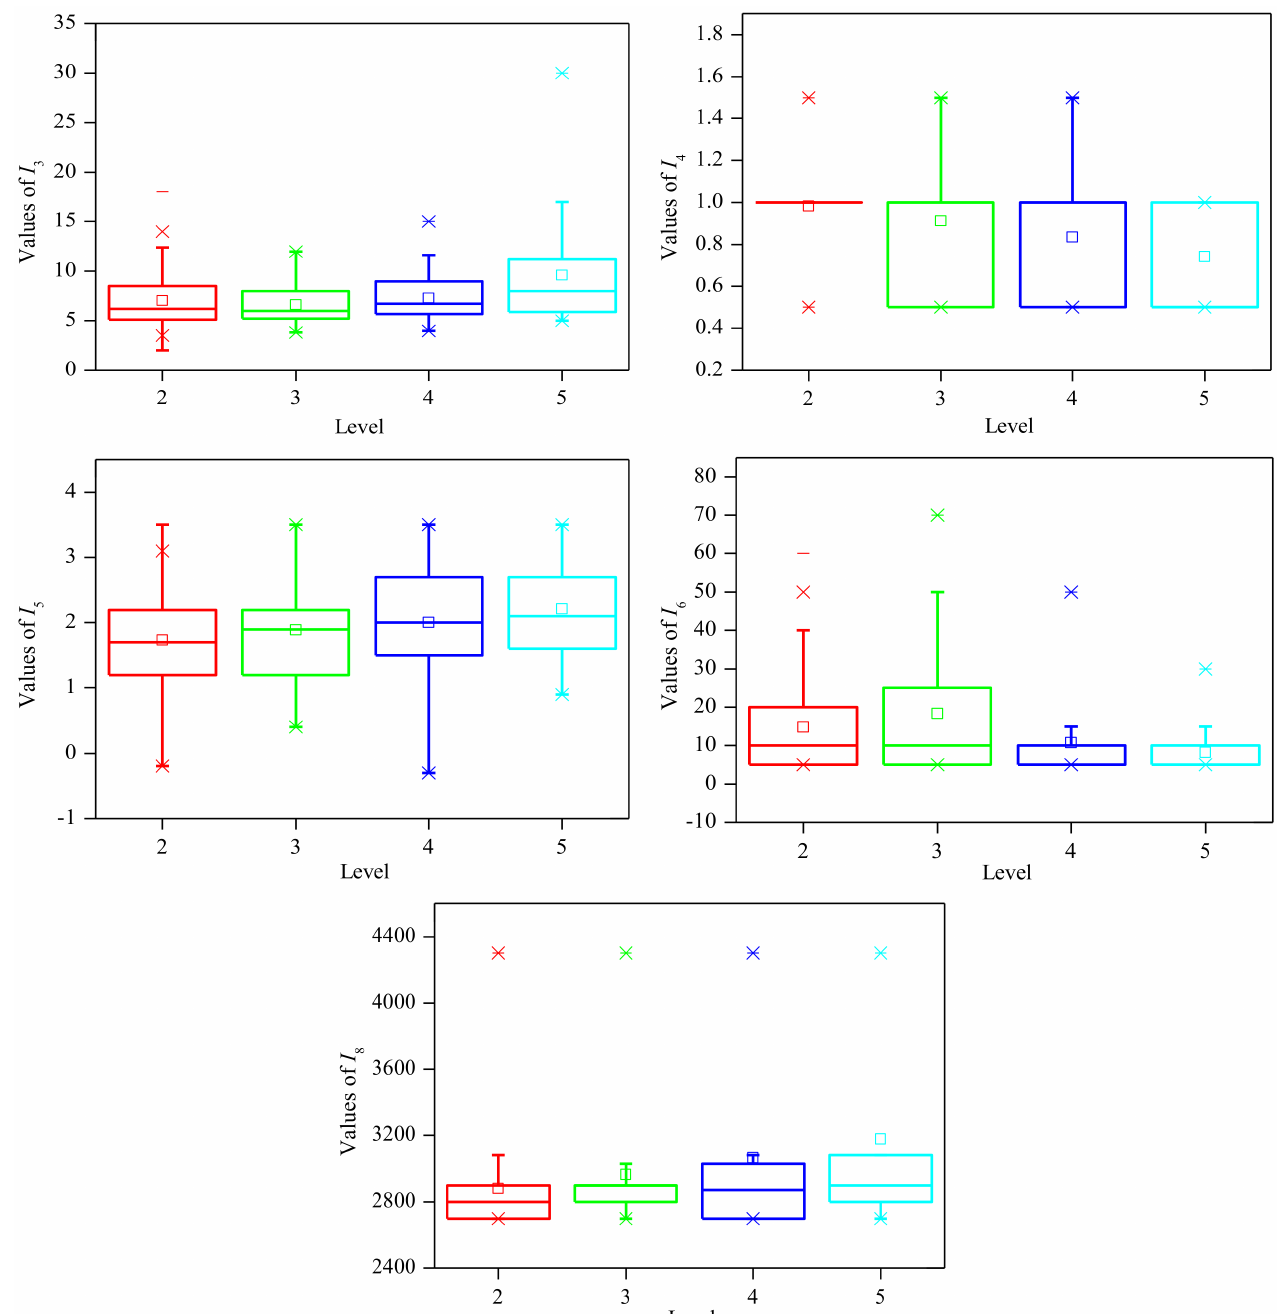
Figure 2. Box plot of indicators for each